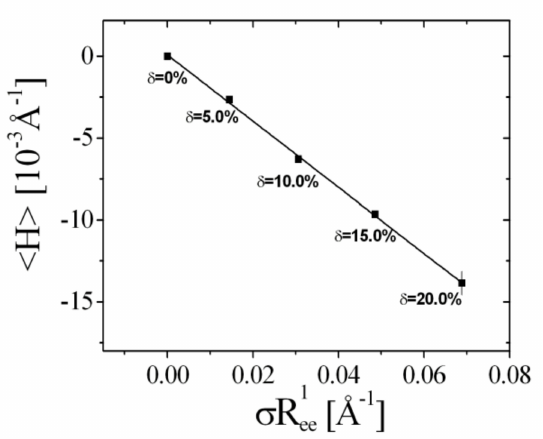
Figure 6. The mean curvature (cid:104) H (cid:105) obtained from the phase inversion temperature for di ff erent polymer amounts of Comb 4 as a function of the particular scaled polymer surface density, σ R 1 ee . The rightmost data point indicates the typical error bar.